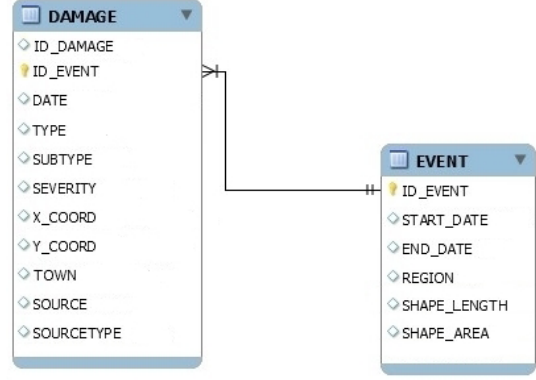
Figure 3. Data structure diagram organizing the connections be- tween the DAMAGE and EVENT feature